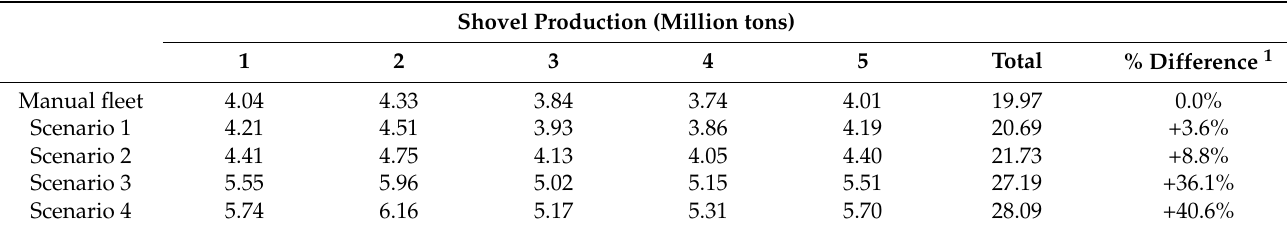
Table 7. Shovel fleet production during the simulation period.